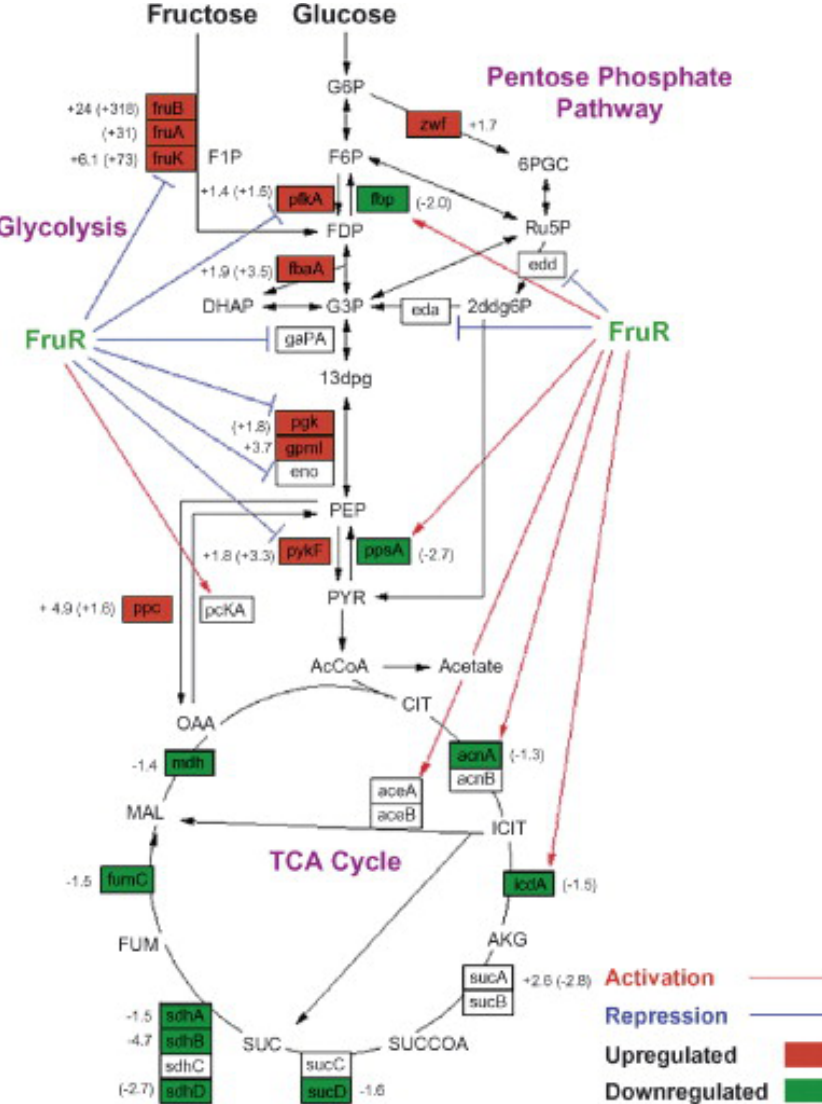
Figure 5. Combined overview of FruR-regulated genes and overall gene expression changes in the central metabolic pathways. The three major central metabolic pathways shown are glycolysis, the pentose phosphate pathway, and the TCA cycle. Values without brackets are protein expression fold changes of P+ fruR cells over P+ WT cells, while values in brackets are the corresponding transcriptional fold changes. Genes that are activated by FruR ( → ) are generally downregulated (green boxes), while those that are repressed by FruR ( ) are generally upregulated (red boxes) in P+ fruR cells vs. P+ WT cells. At least two biological samples, each with three technical replicates, were analyzed. Reprinted from Ow et al. [62], with permission from Elsevier. Copyright (2007) Elsevier B.V.